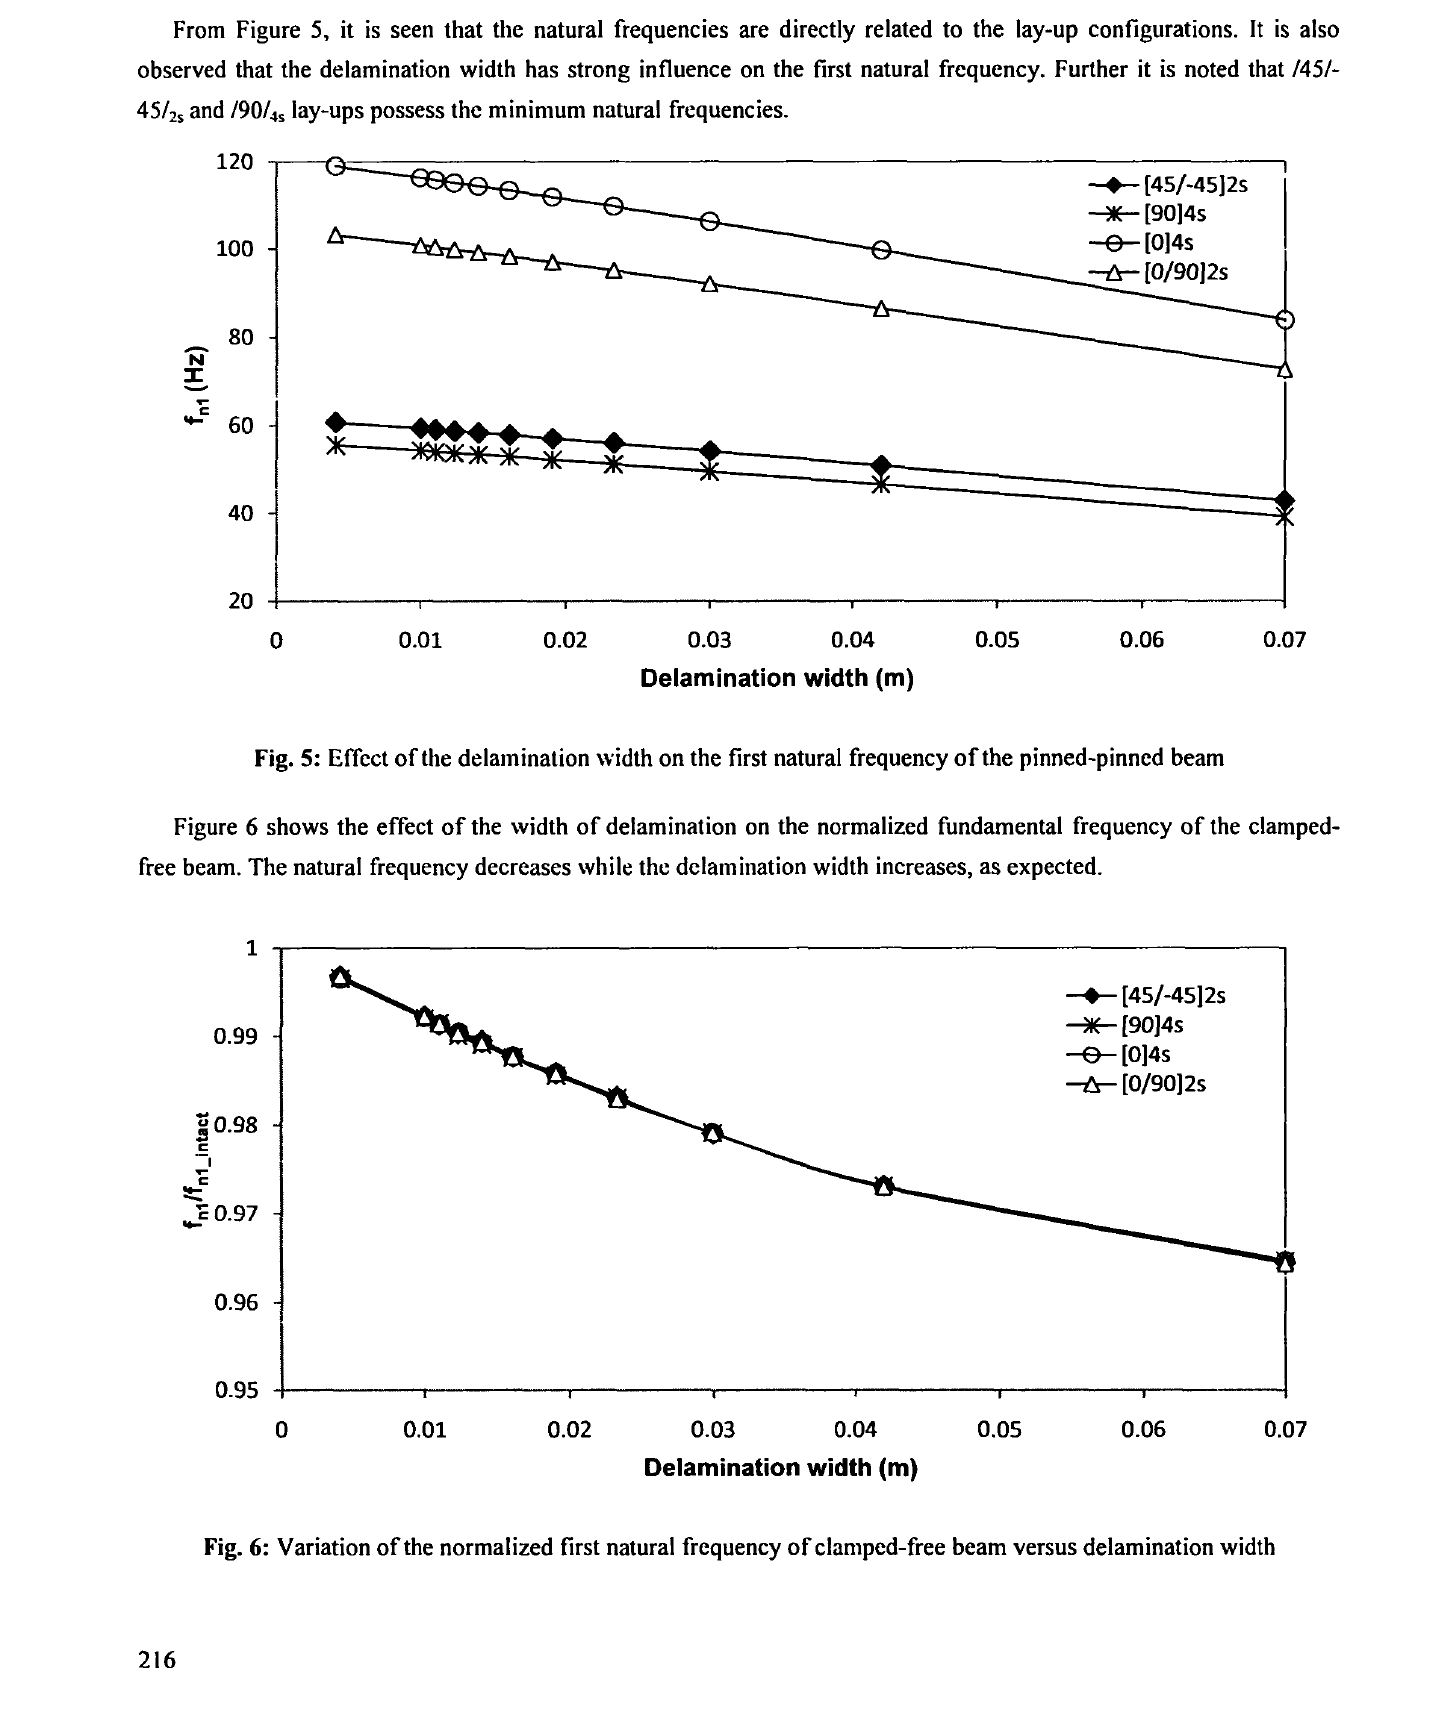
Fig. 6: Variation of the normalized first natural frequency of clamped-free beam versus delamination width